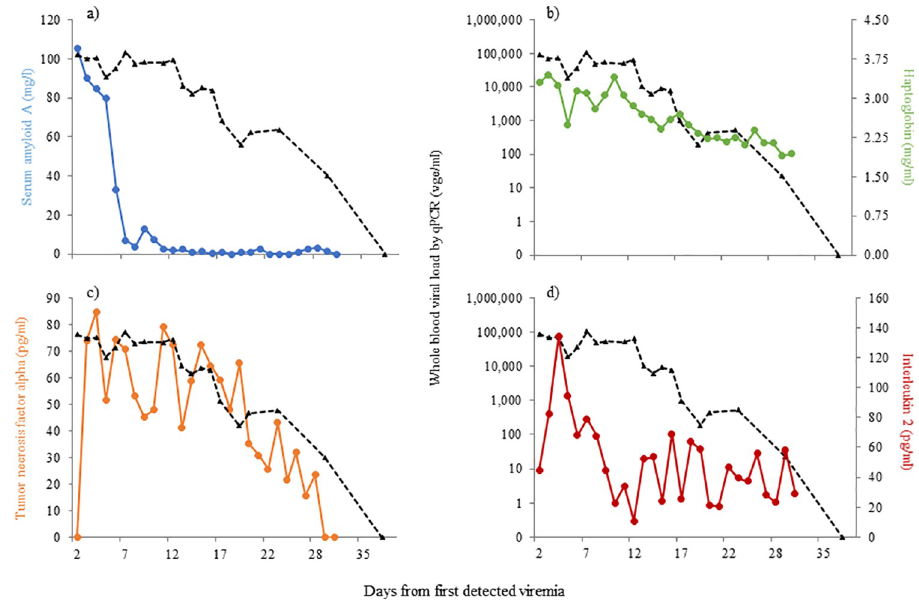
Fig 6. Biomarker concentrations during EEHV3B viremia in a male African elephant aged 4 y 11 m for serum amyloid A (a), haptoglobin (b), tumor necrosis factor alpha (c) and interleukin 2 (d).